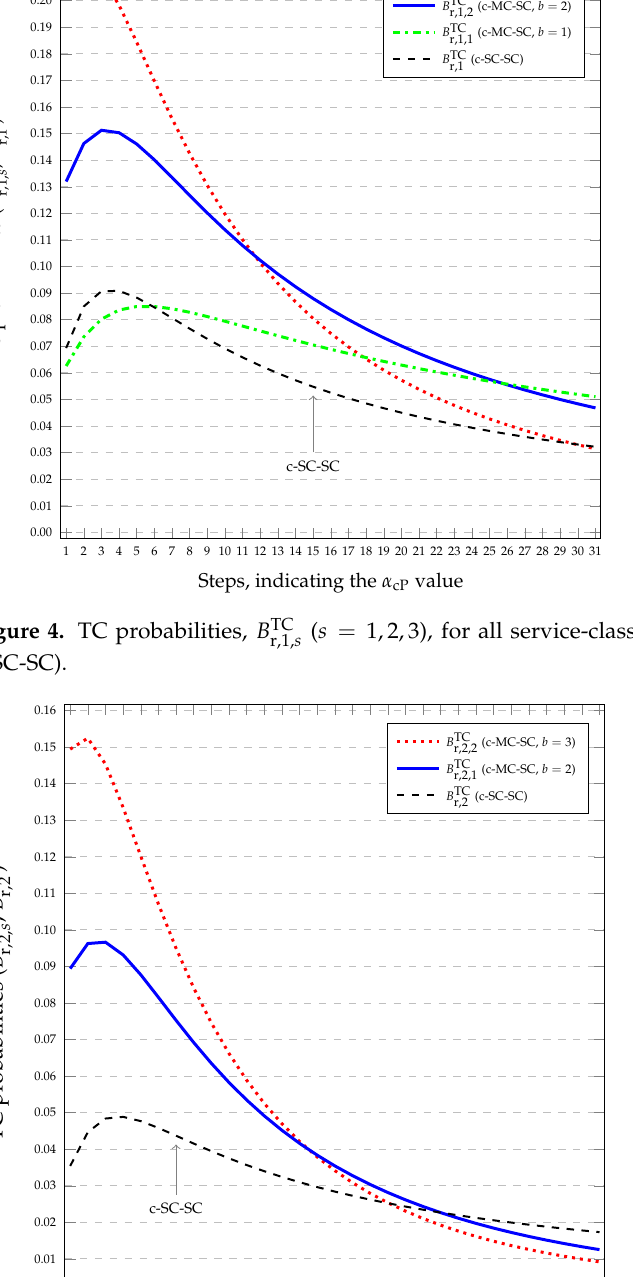
Figure 5. TC probabilities, B TC